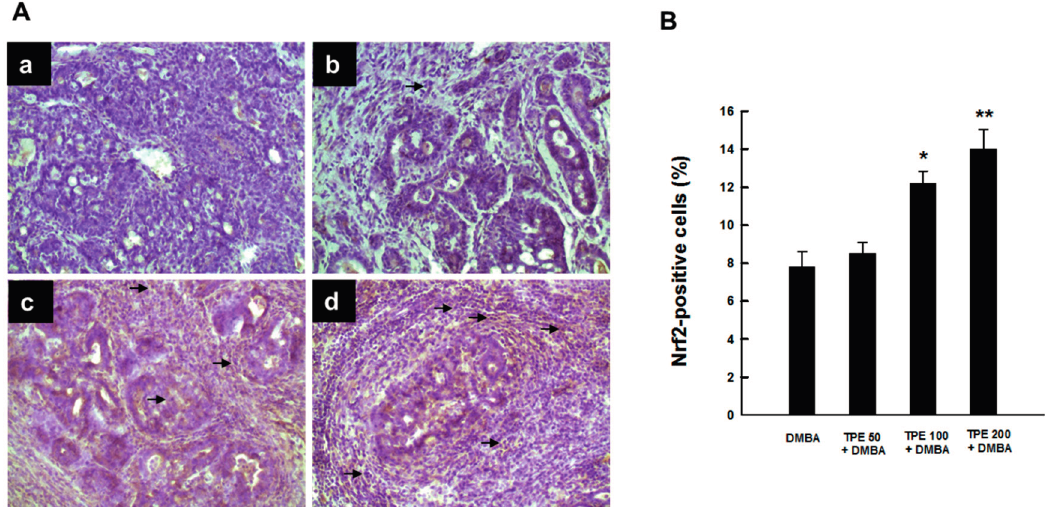
Figure 5. Effect of TPE on intratumor Nrf2 expression during DMBA-initiated